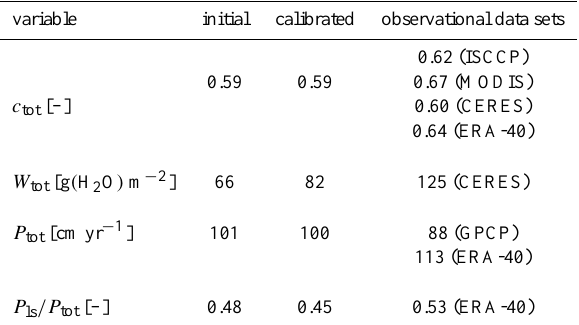
Table 4. Globally and annually averaged values as calculated by the proposed scheme with two parameter sets in comparison with the available observational